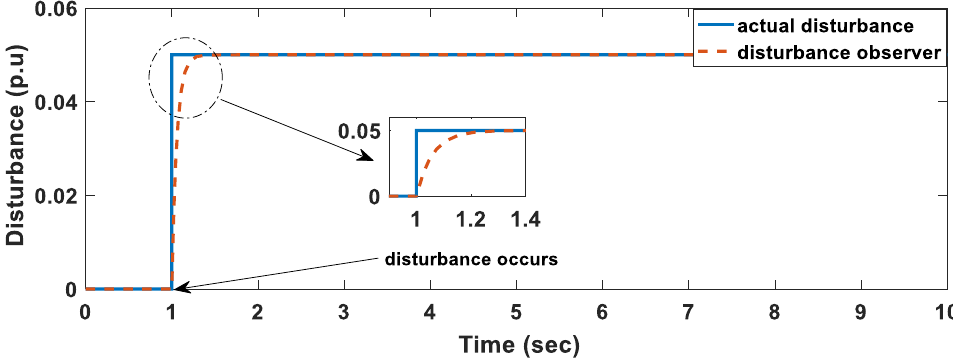
Figure 6. Estimated and actual disturbance for scenario